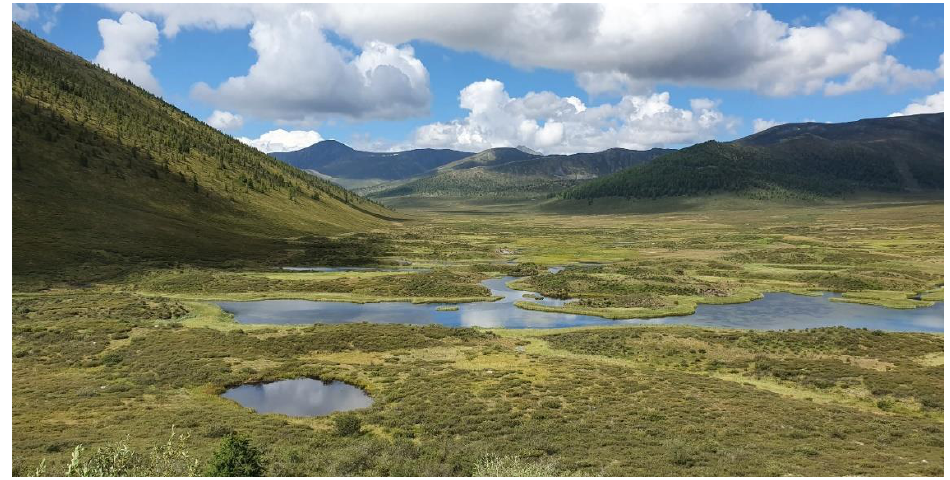
Figure 9. A system of lakes in the Adyr-Khem river valley at Alash plateau; southern slope of the Western Sayan montane region, Republic of Tuva, Russia. (photo by S. Kirpotin, 5 August 2021).